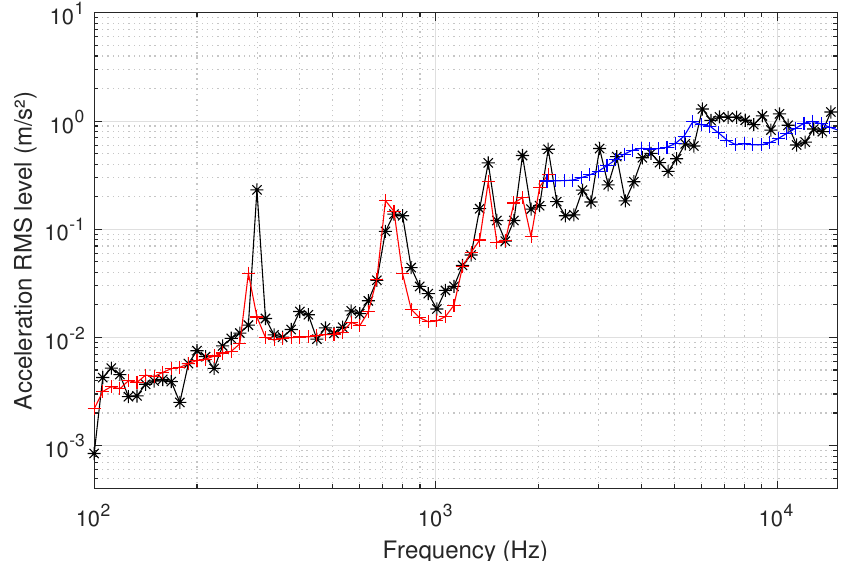
Figure 21. Full-frequency test–simulation comparison at point (b), one-twelfth-octave frequency band representation. The experimental response (black curve with stars) is compared with the combination of the FE-BEM results (red curve with +) and SEA results (blue curve with +).